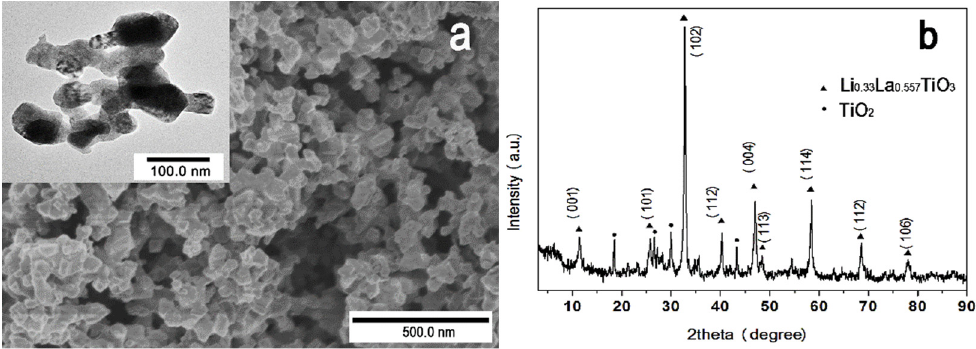
Figure 1. ( a ) SEM and TEM (inset) images and ( b ) XRD pattern of Li 0.33 La 0.557 TiO 3 particles. Table 1. LLTO particles prepared by various methods.